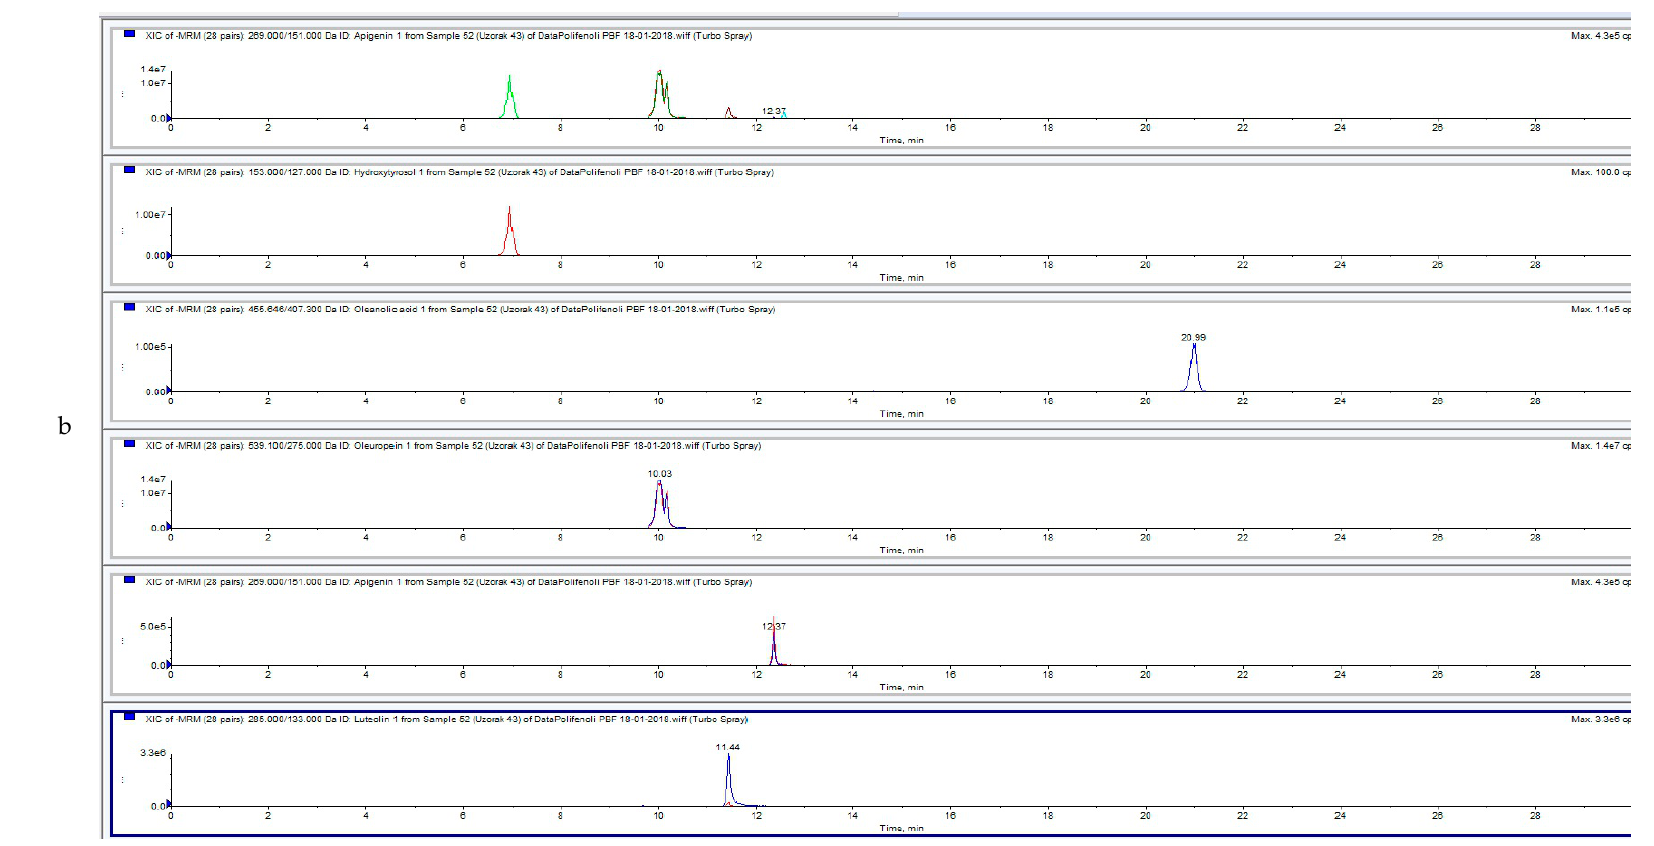
Figure 3. ( a ) UPLC-MS/MS analysis chromatogram of HVED treated (with nitrogen) OLE (OLN1)—total ion current (TIC). ( b ) UPLC-MS/MS analysis chromatogram of HVED treated (with nitrogen) OLE (OLN1) .